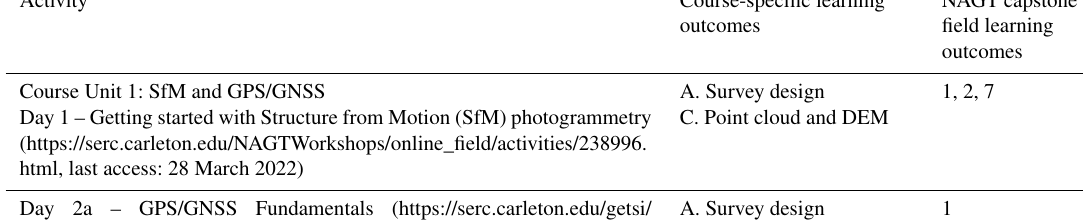
Table 1. Activities by day and alignment with course-specific and NAGT learning outcomes.